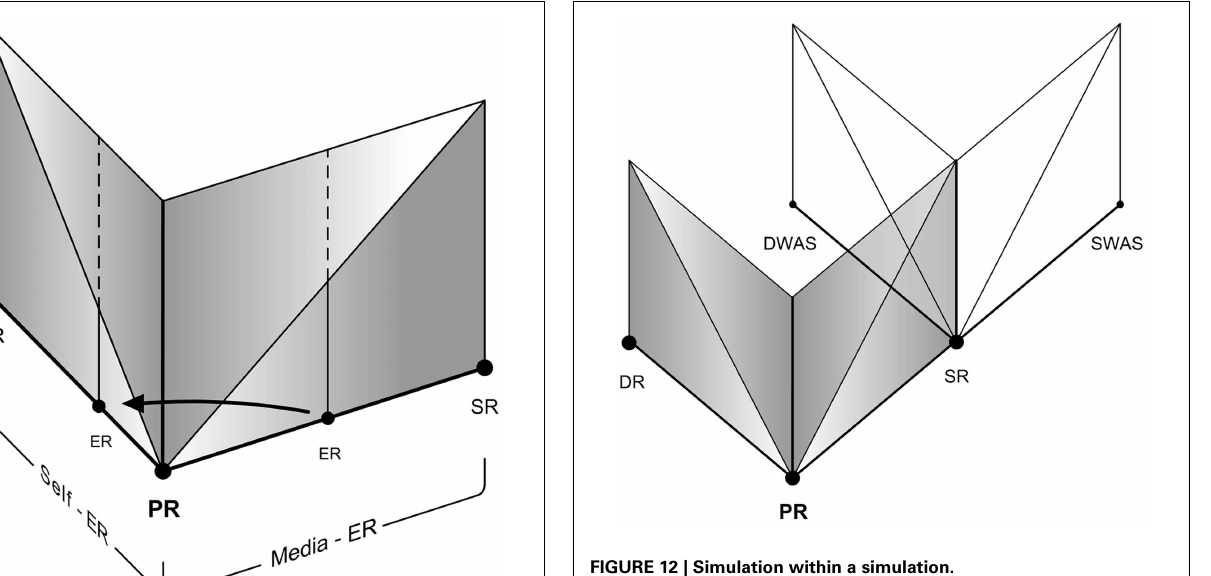
FIGURE 12 | Simulation within a